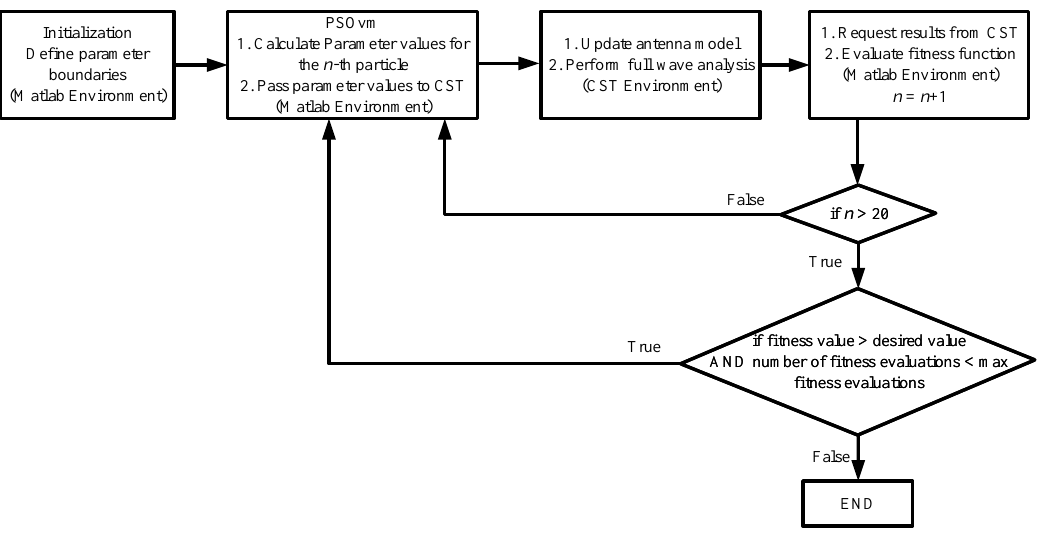
Figure 1. Flowchart of the optimization